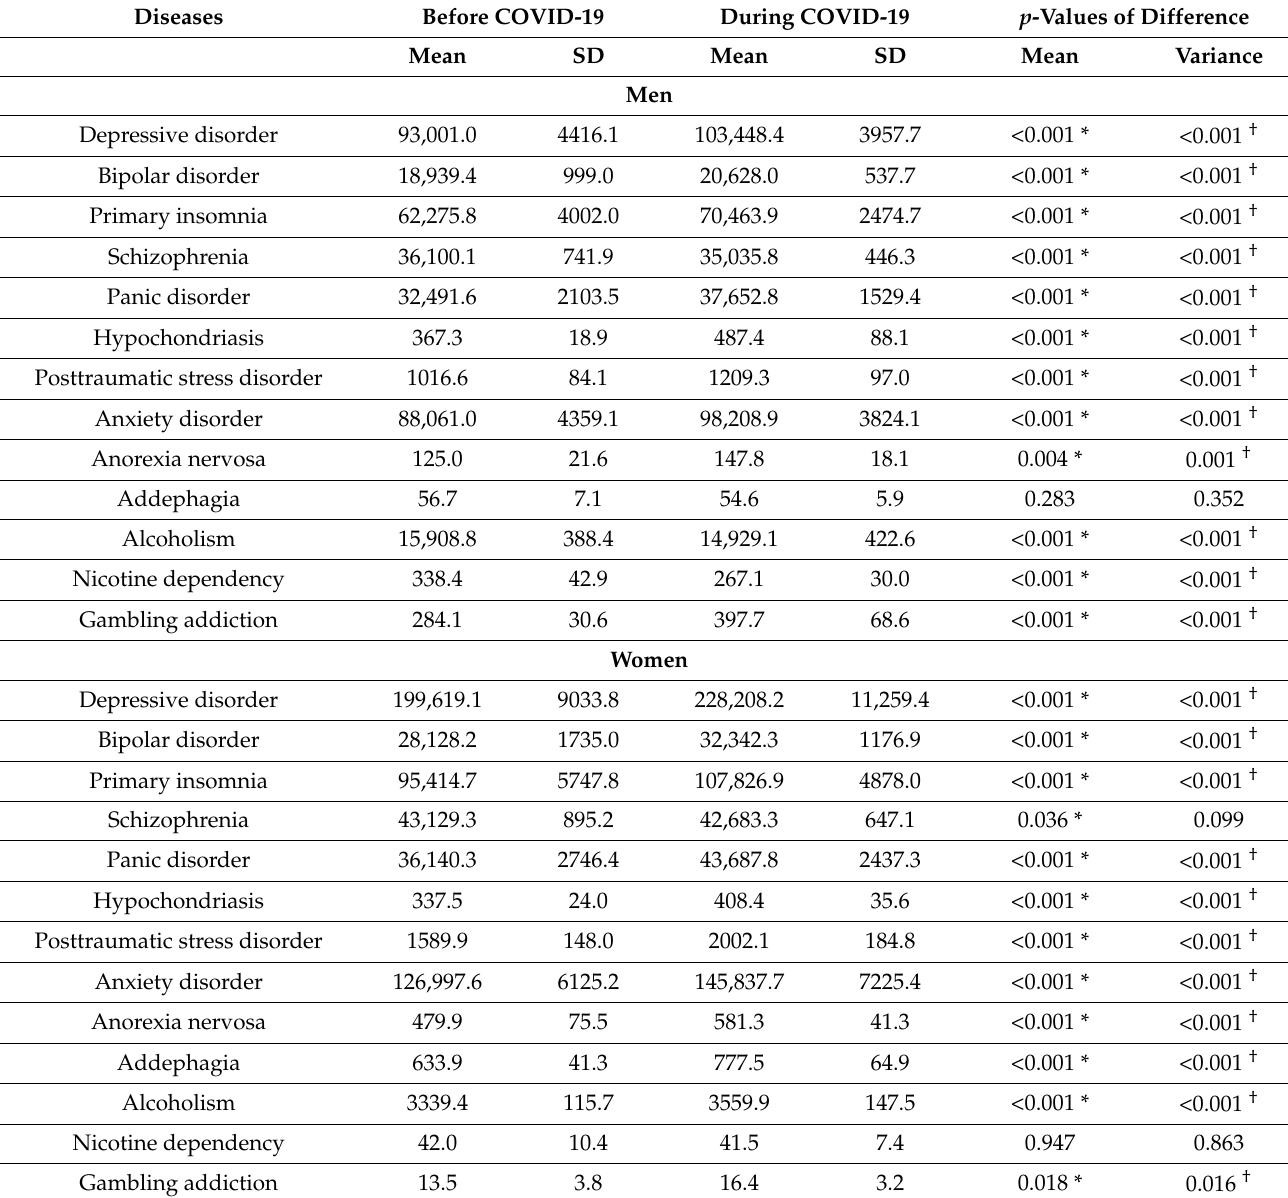
Table 2. Mean, standard deviation of incidence of diseases before and during COVID-19, and their difference in the subgroup by